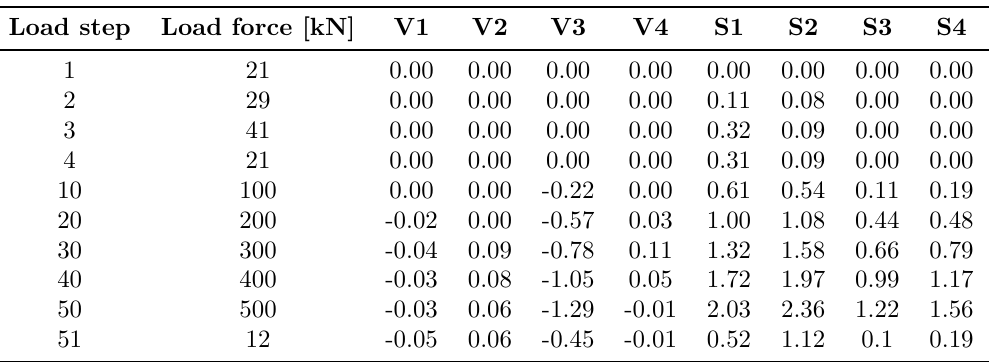
Table 2. Measured deformations during individual load steps [mm].